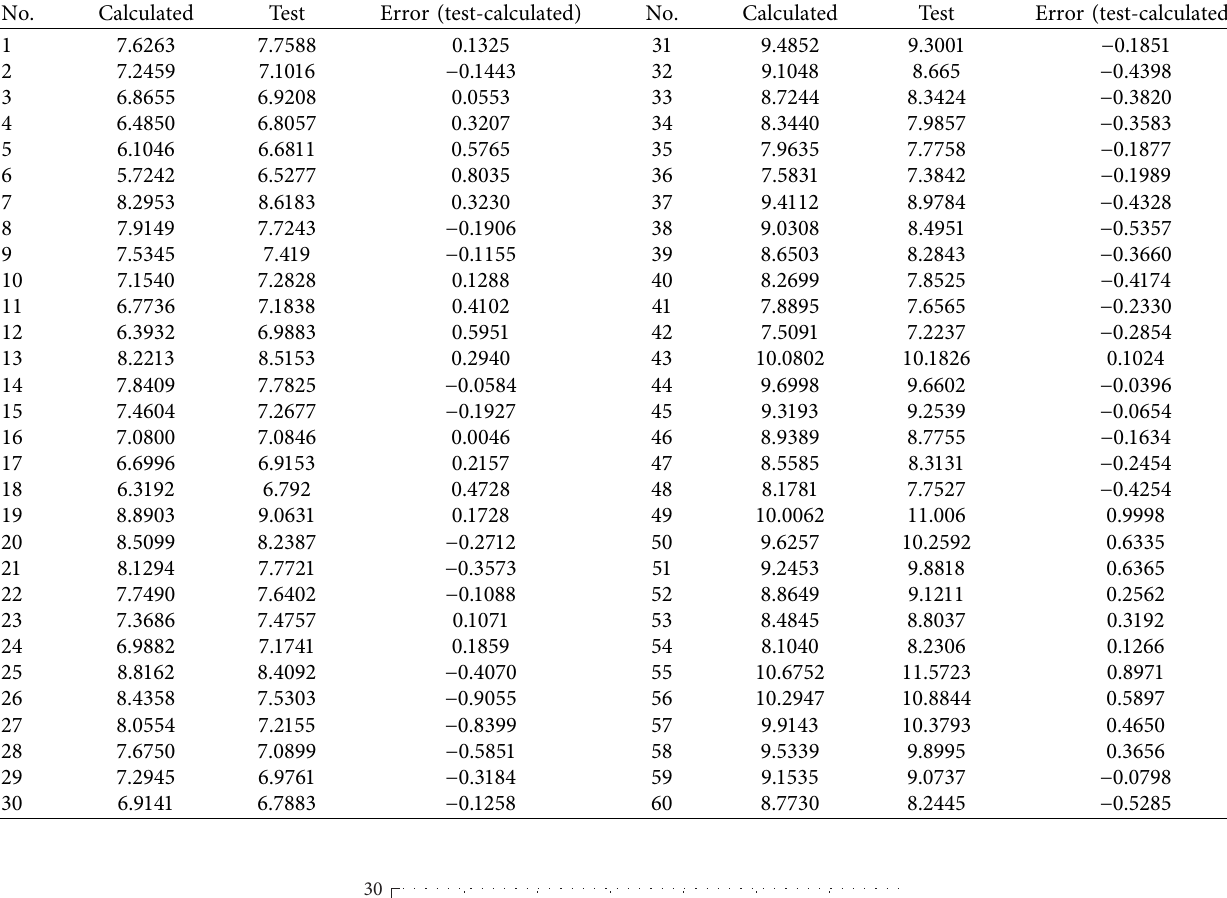
Table 6: Summary of the test results and calculated results by the comprehensive equation of dielectric